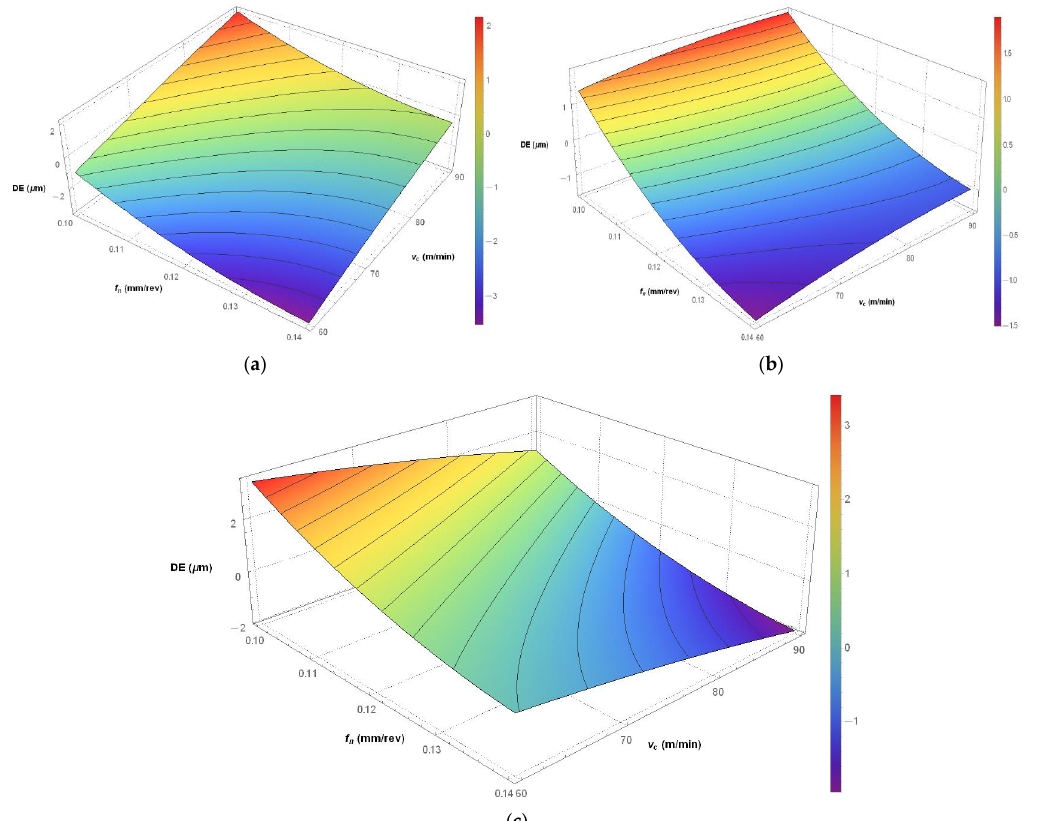
Figure 6. Simulations based on Equation (2) developed to predict the hole diameter error for: ( a ) the first kinematic system ( b ) the second kinematic system; ( c ) the third kinematic